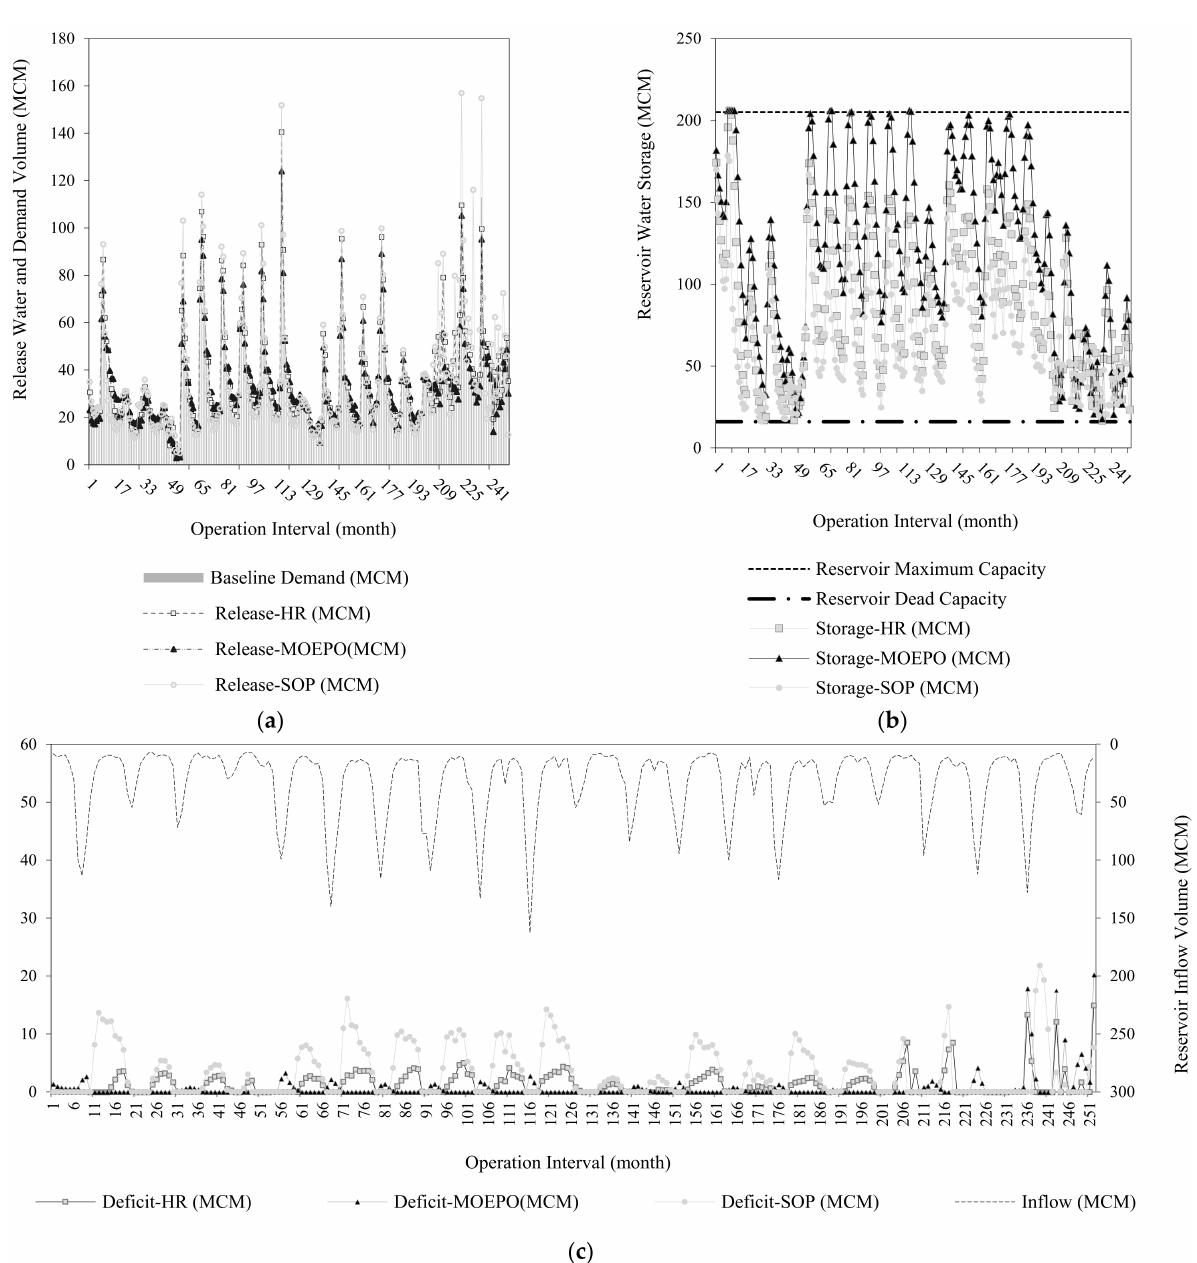
Figure 9. Comparison of: ( a ) Released volume; ( b ) Storage volume; ( c ) Deficit volume, corresponding to the first